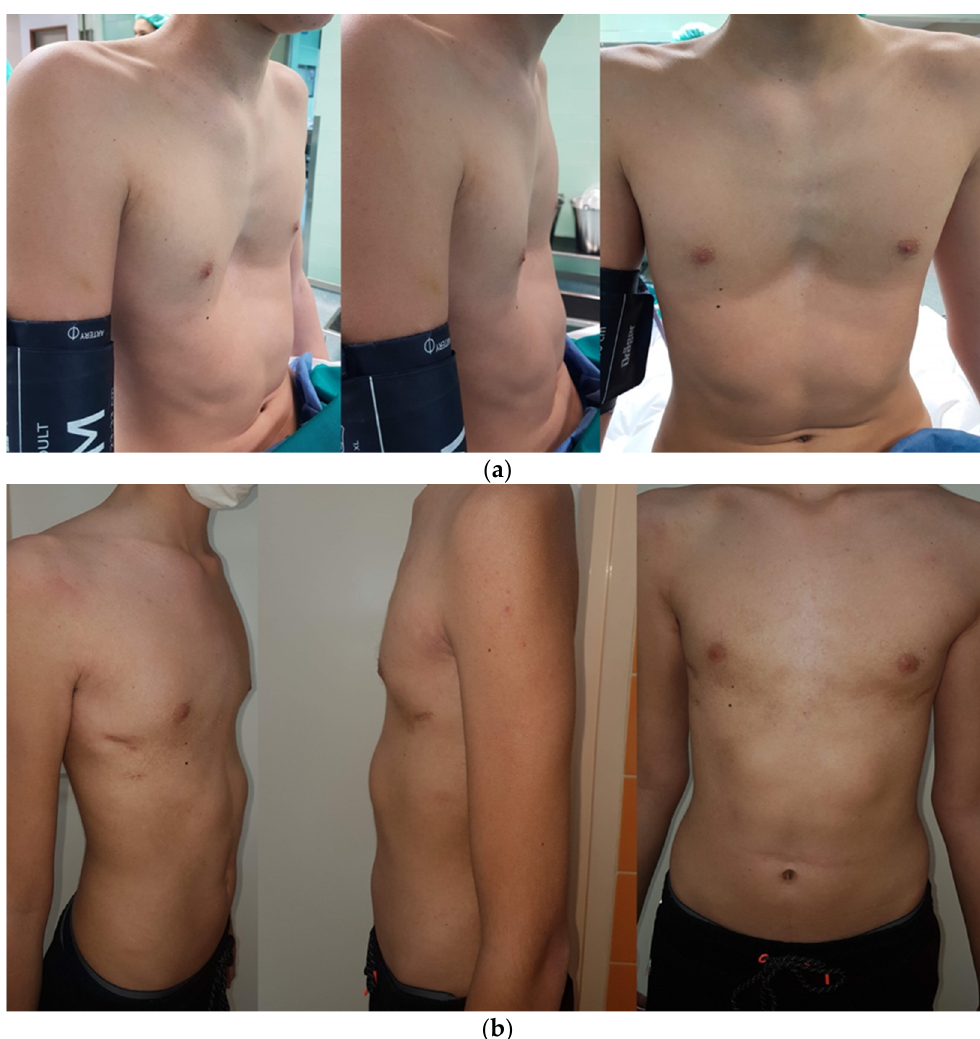
Figure 1. ( a ) Preoperative presentation of 16-year-old male patient with pectus excavatum scheduled for corrective Nuss procedure. ( b ) Postoperative result of the same patient two weeks after surgery.